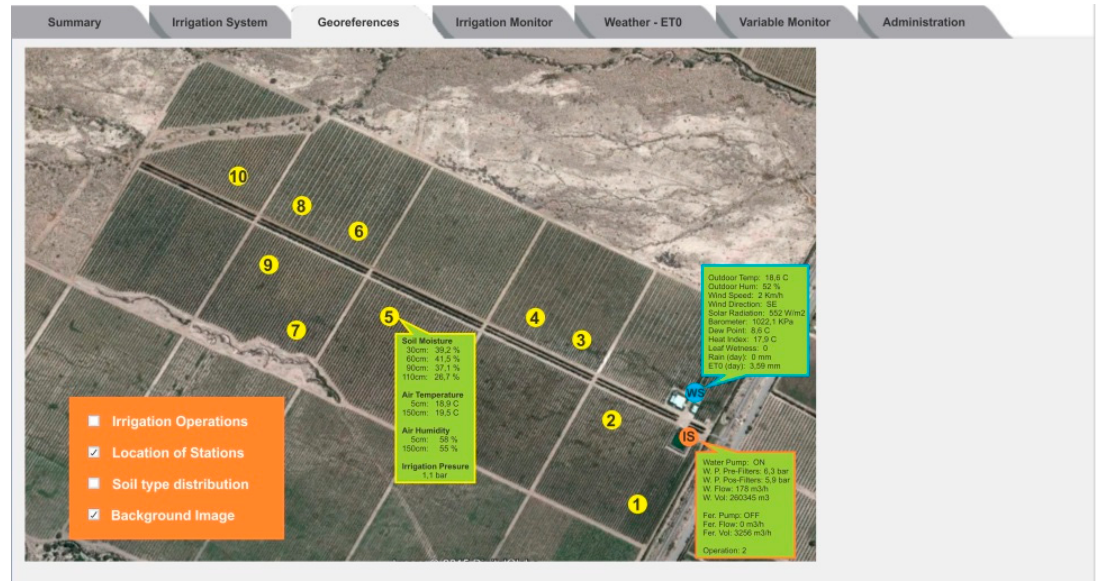
Figure 5. The Georeference tab presents information from each measurement station.